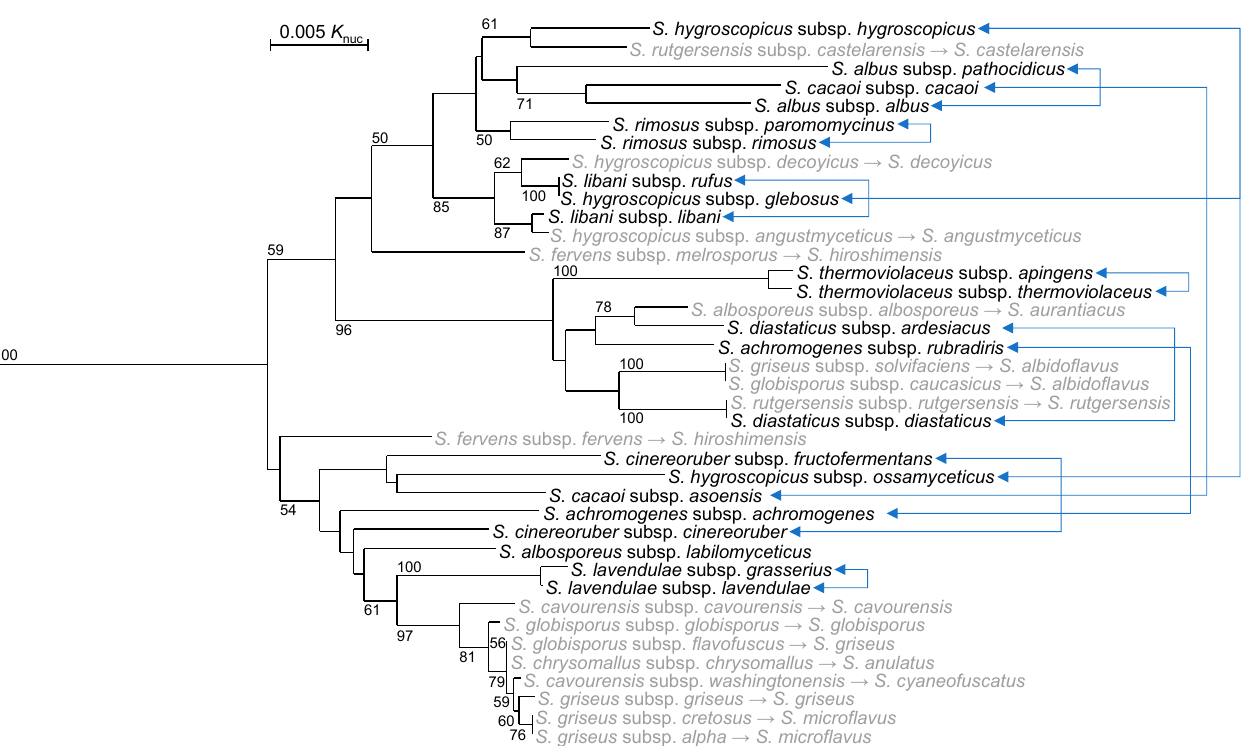
Figure 3. Phylogenetic tree of all Streptomyces subspecies with validly published names based on 16S rRNA gene sequences. Subspecies indicated in gray were reclassified to species before 2011, as shown after each gray arrow. Twenty-three subspecies present in 2012 are indicated in black. Subspecies pairs (or trios) within the same species are connected by light blue lines with double arrows in this figure. Numbers on branches indicate the percentage bootstrap values of 1000 replicates; only values >50% are indicated. Kitasatospora setae NBRC 14216 T (AB184576.2) is used for an outgroup (not shown) to indicate the root of this tree.